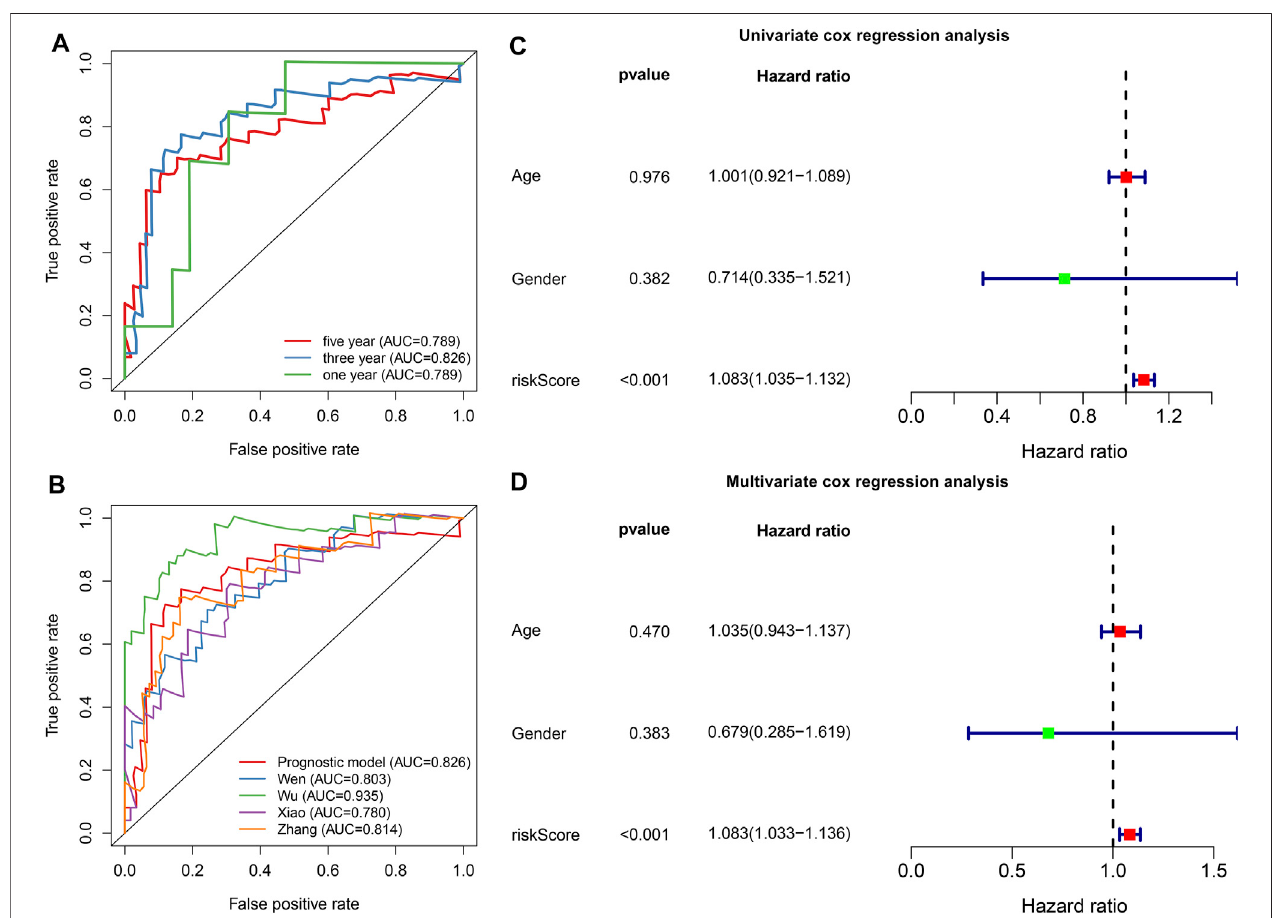
FIGURE3| Thehypoxicgenesignaturerobustlyandindependentlypredictsosteosarcomapatients ’ prognosisintheTARGETcohort. (A) Time-independentROC curves of 1-, 3-, and 5-years survival based on risk score. (B) Comparisons of AUCs among different gene signatures for osteosarcoma patients. (C, D) Univariate and multivariate cox regression analyses for the associations between prognosis and age, gender, and risk scores.